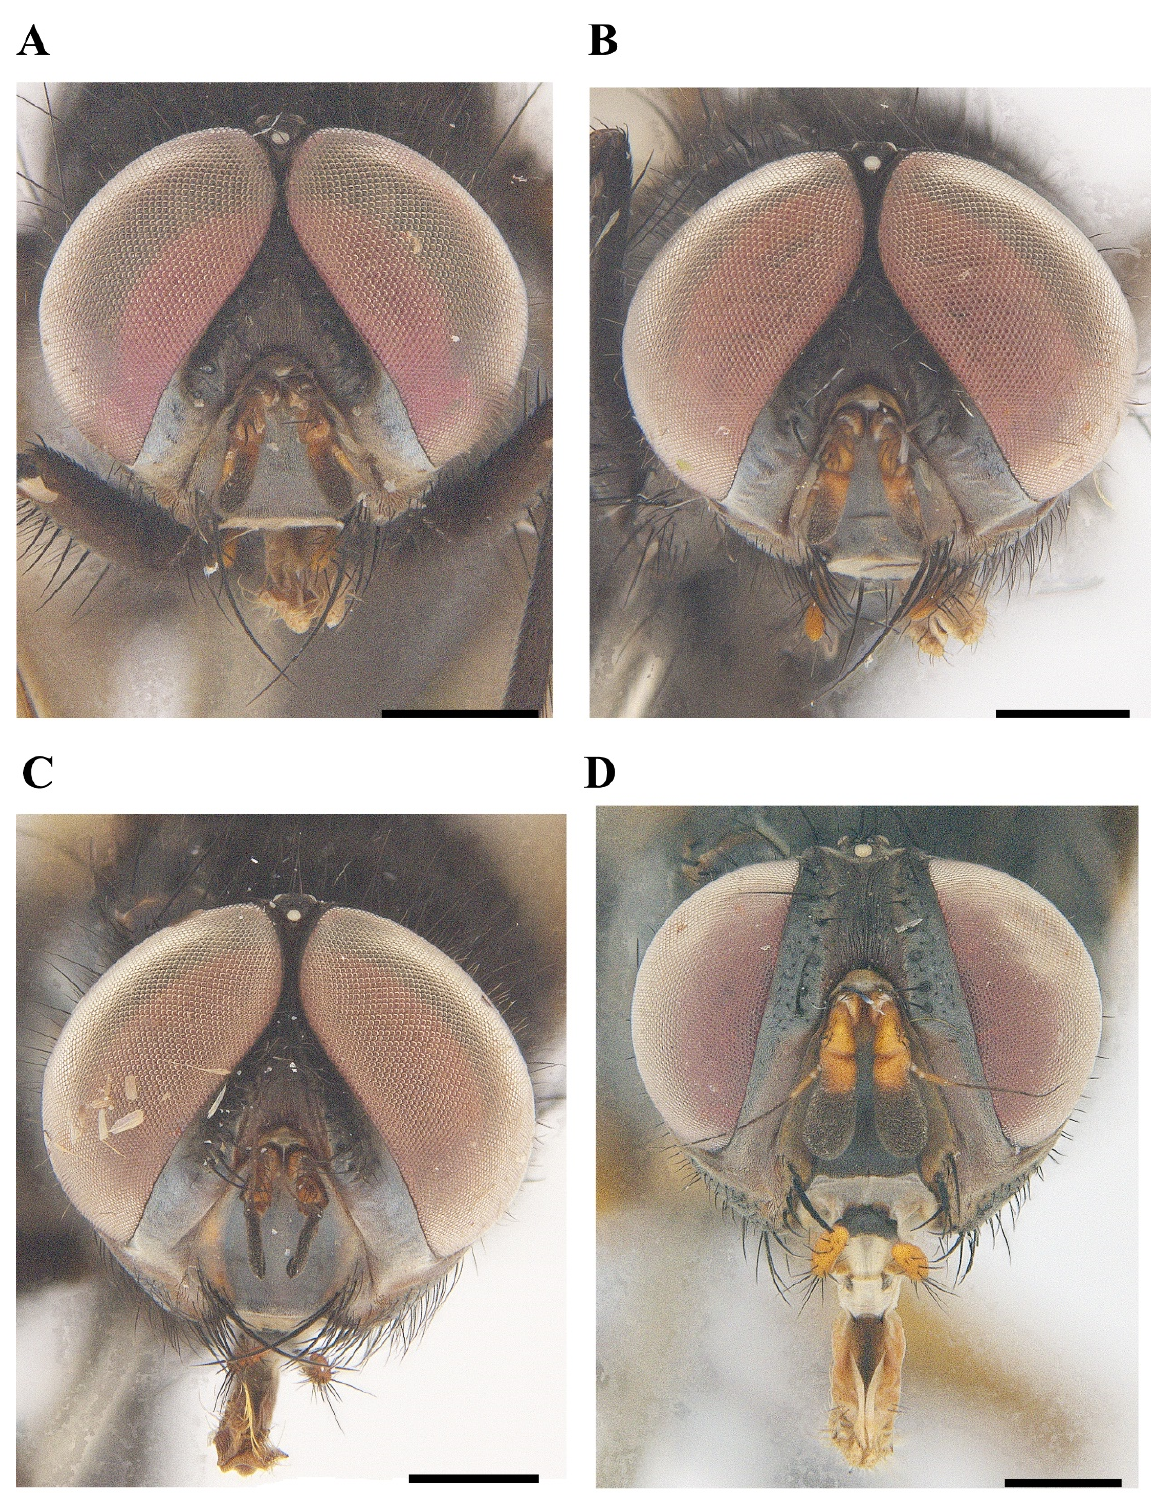
Figure 1. Anterior view of Macquartia spp. male heads. ( A ) M. brunneisquama sp. nov. ( B ) M. chinensis sp. nov. ( C ) M. flavipedicel sp. nov. ( D ) M. flavifemorata sp. nov. Scale bar = 0.5 mm.